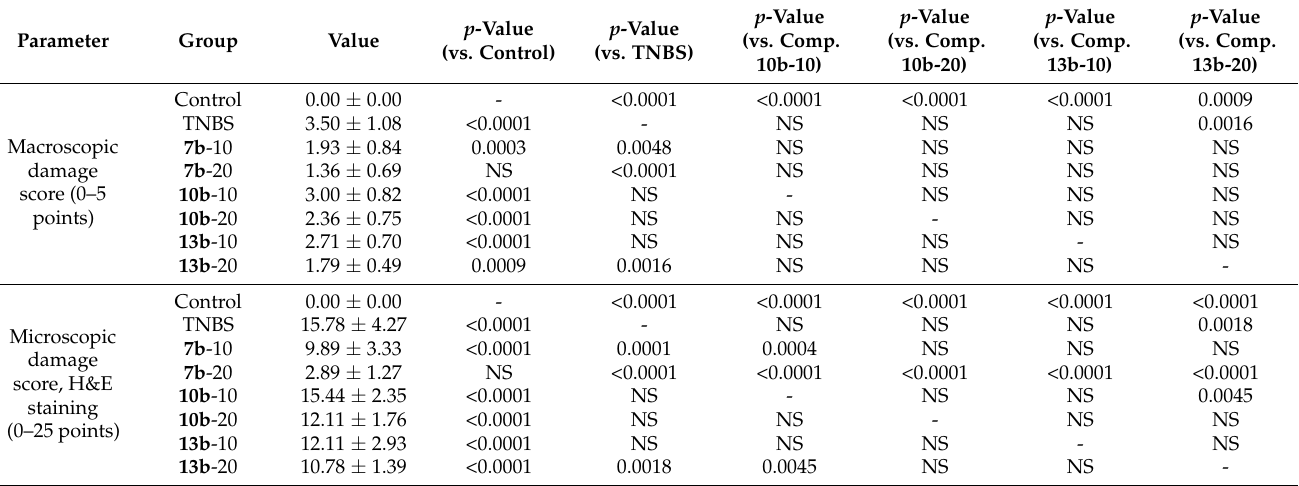
Table 2. The impact of compounds 7b , 10b , and 13b on macroscopic damage of the colon tissues and microscopic damage of the colon tissues in H&E staining in experimental